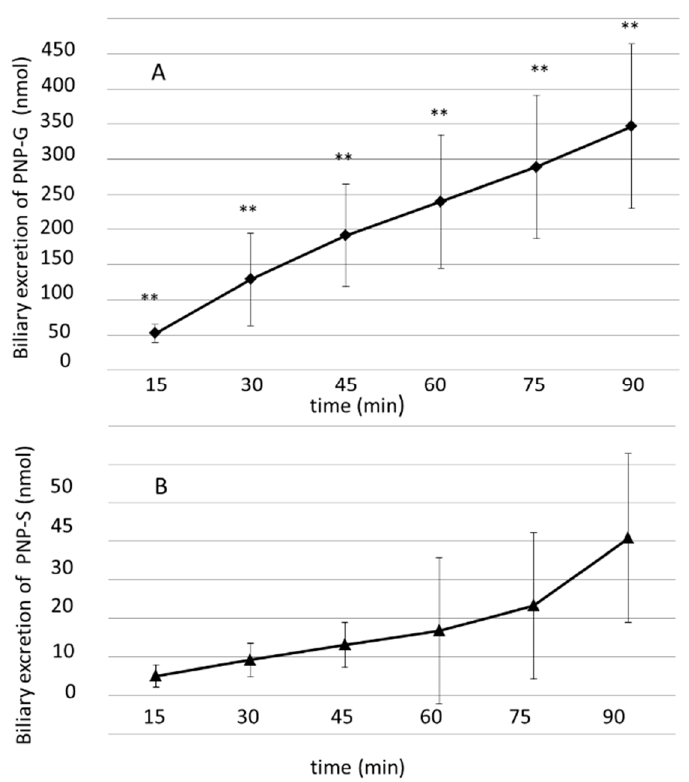
Figure 3. Biliary excretion of PNP-G ( ♦ ) (Panel A ) and PNP-S ( ▲ ) (Panel B ) measured in 90 min perfusion of 500 µM PNP in the small intestine (proximal jejunum). Values represent the mean ± S.D. of eight rats. At low PNP-S values, the data of S.D. are not indicated, because they are smaller than the symbols. Significant difference between the values of PNP-G and PNP-S: ** p < 0.01.